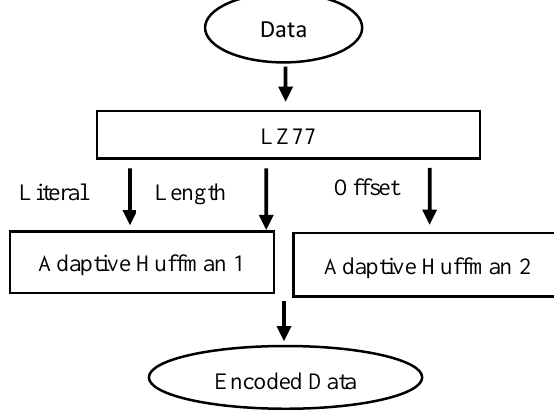
Figure 5. Generic Representation of Improvised GZIP